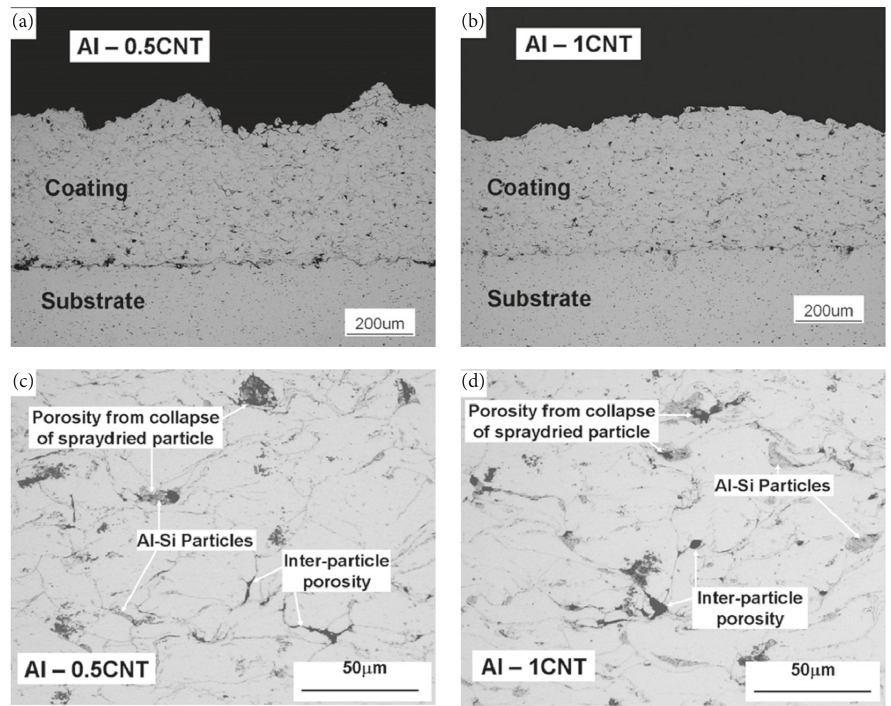
Figure 12: SEM imaging of the cross section of cold-sprayed CNT-Al MMC coatings with different CNTcontents: (a) CNTcontent of 0.5%, (b) CNT content of 1%, and (c, d) high-magnification view